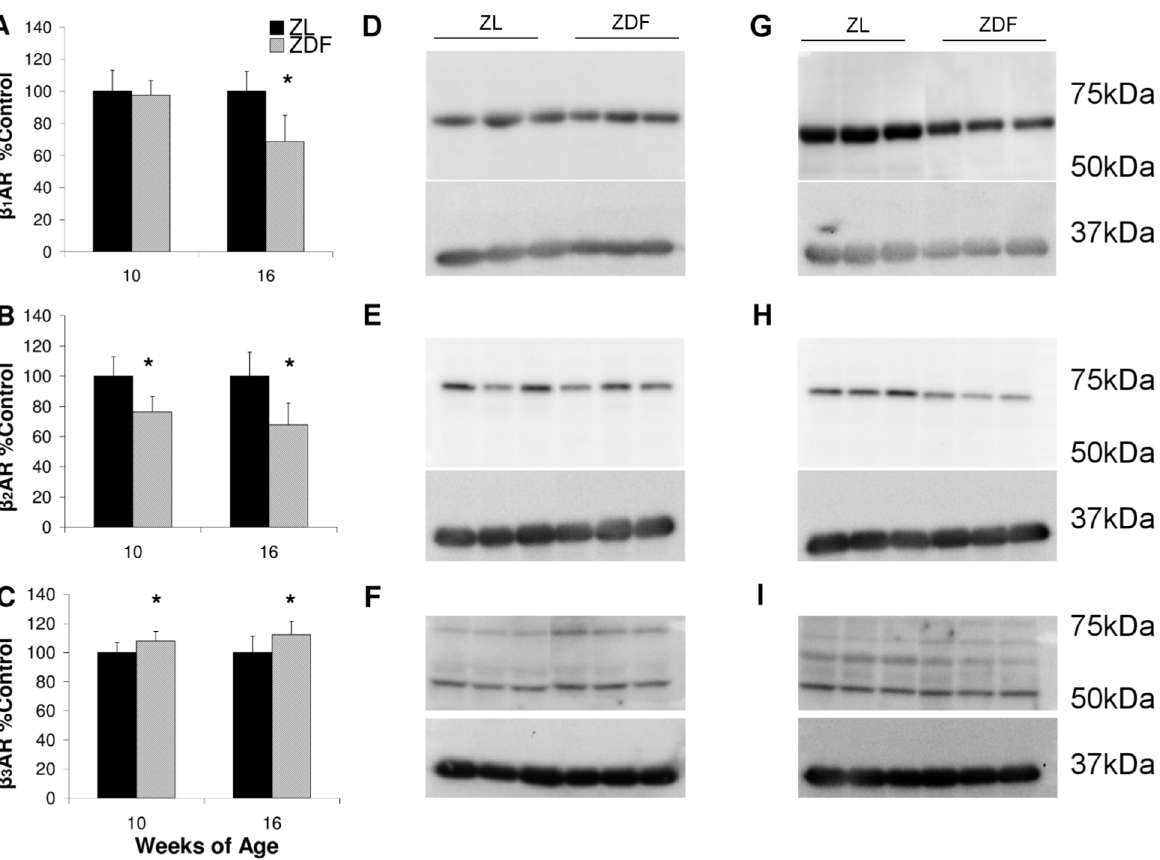
Fig 3. Western blot analysis of cardiac β -AR subtypes. Expression relative to ZL of cardiac β 1 -AR (A), β 2 -AR (B), and β 3 -AR (C) at 10 and 16 weeks of age. Representative 10 week blots for cardiac β 1 -AR (D), β 2 -AR (E), and β 3 -AR (E). Representative 16 week blots for cardiac β 1 -AR (F), β 2 -AR (G), and β 3 - AR (H). Relative expression compared with ZL is combined from at least 3 Western blot analyses. n = 3 per group. Data are mean ± SD. * p < 0.05 vs ZL, Student ’ s t-test.